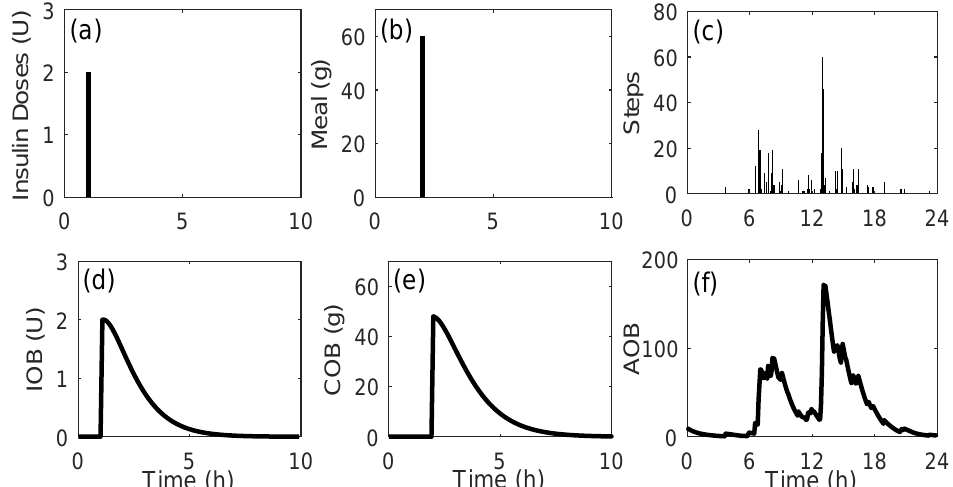
Figure 2. Utilization of the physiological models to generate features. ( a – c ) represent a single insulin dose, a single meal consumed, and the steps performed over a single day, respectively. ( d – f ) are the insulin on board (IOB), carbohydrate on board (COB), and activity on board (AOB) obtained by the physiological